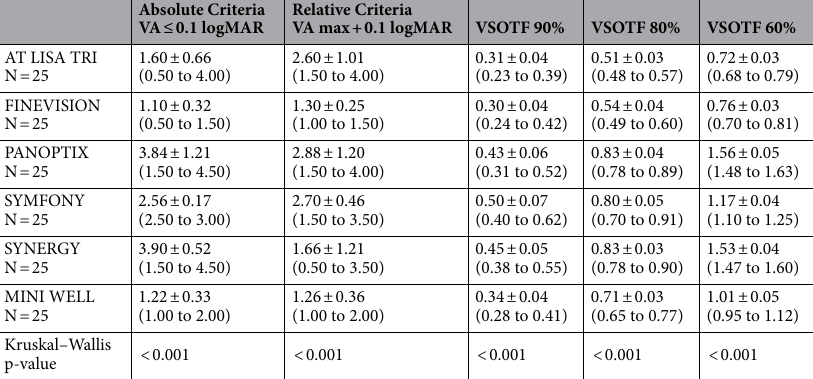
Absolute Criteria VA ≤ 0.1